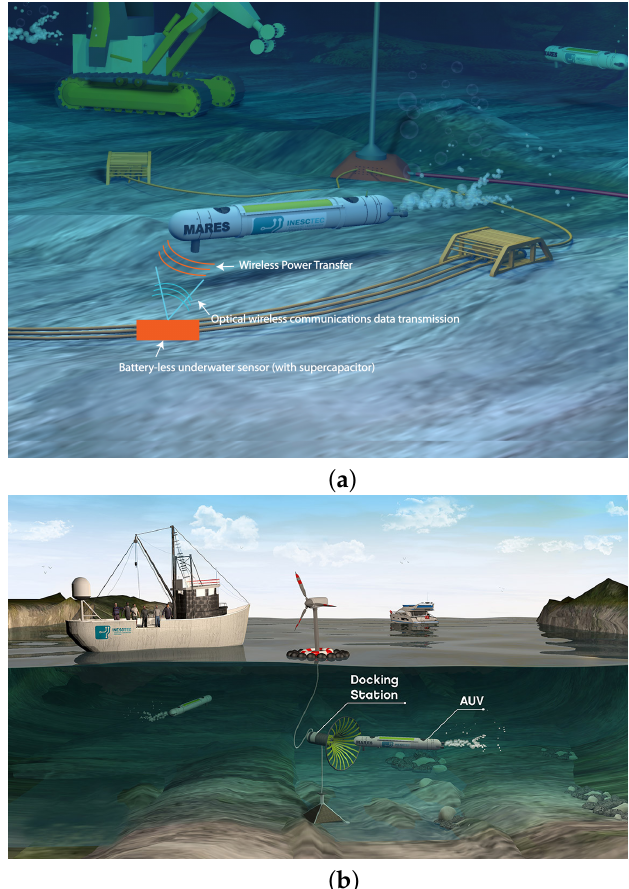
Figure 1. ( a ) Underwater wireless energy and communications enabling a long-term deep-sea presence. ( b ) Underwater wireless data transfer from the AUV to the docking